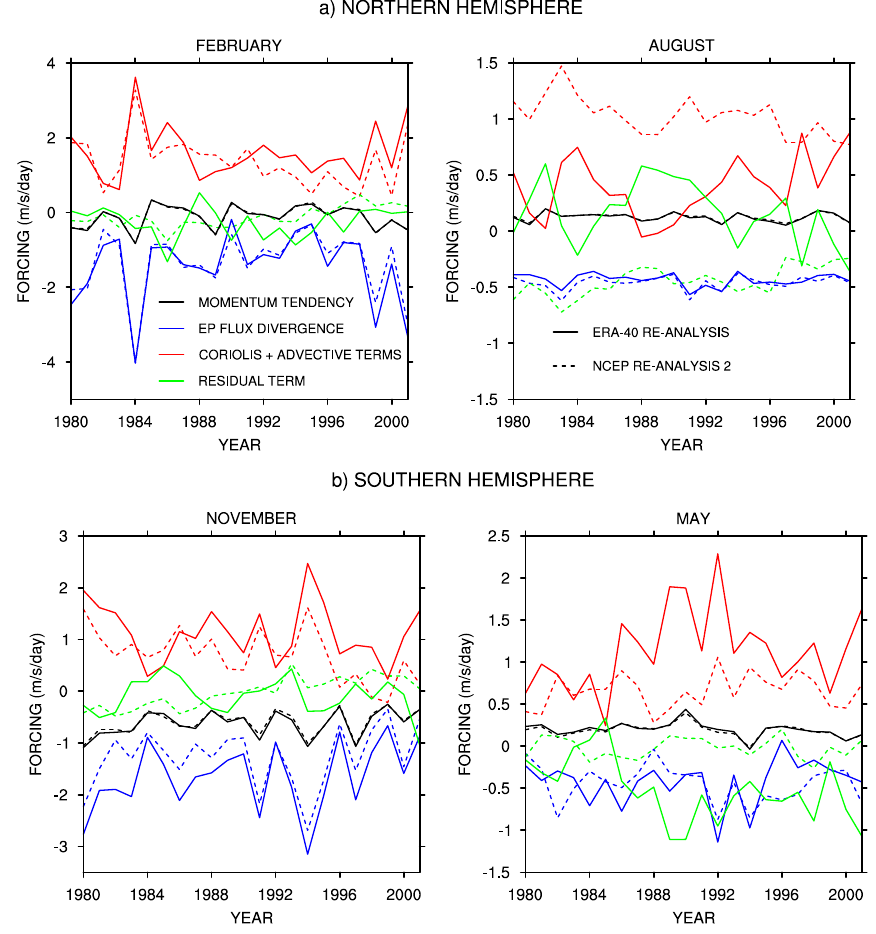
Fig. 8. Times series of the momentum tendency and its forcing terms averaged between 100 and 20hPa and between 50 ◦ –80 ◦ for the ERA-40 (solid lines) and R-2 (dashed lines)